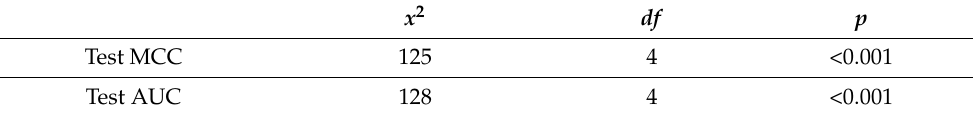
Table A7. The results of the Kruskal–Wallis test (non parametric one-way ANOVA).